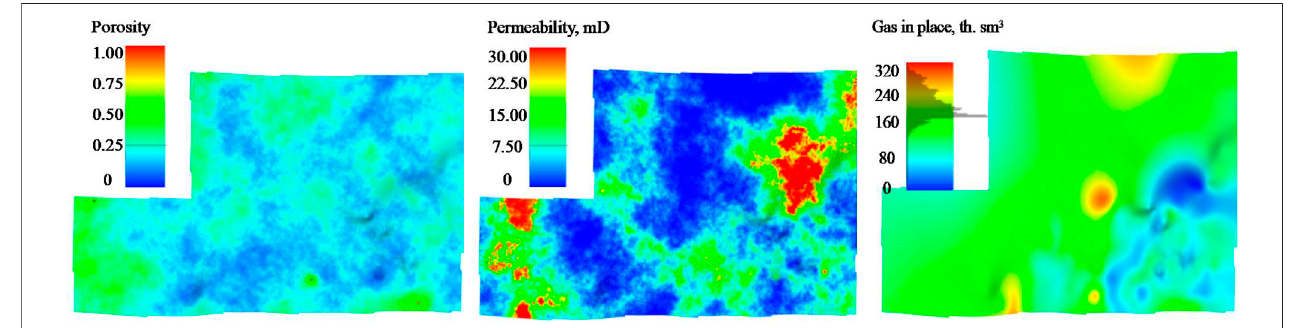
FIGURE 5 | Porosity/permeability/gas content parameter fi elds of the fracture system in the coal seam.